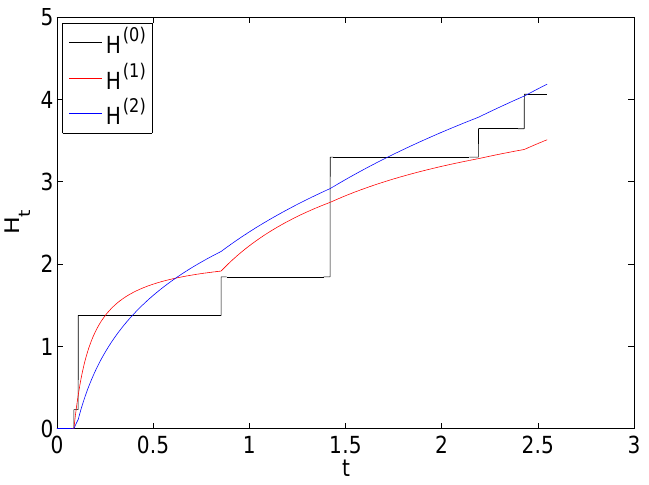
Figure 3: Simulated paths of the processes H (1) and H (2) where a = 2 is chosen. For comparison, a path of the simple com- pound Poisson process H (0) with Exp( a )-distributed jumps is added, which has the same marginal distribution. For all pro- cesses, the same jump times are